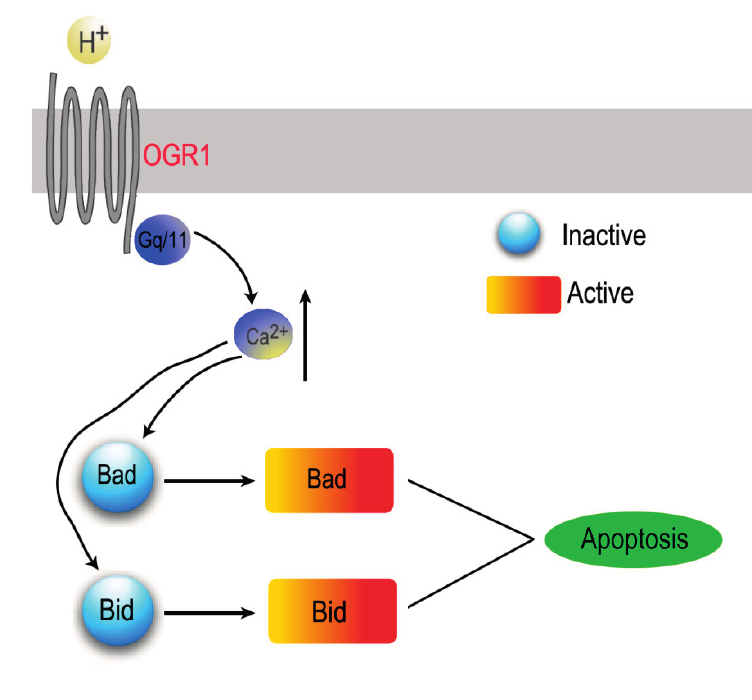
Figure 2. Schematic diagram of the potential mechanism of proton-sensing receptor OGR1 involved in acid-induced apoptosis of endplate